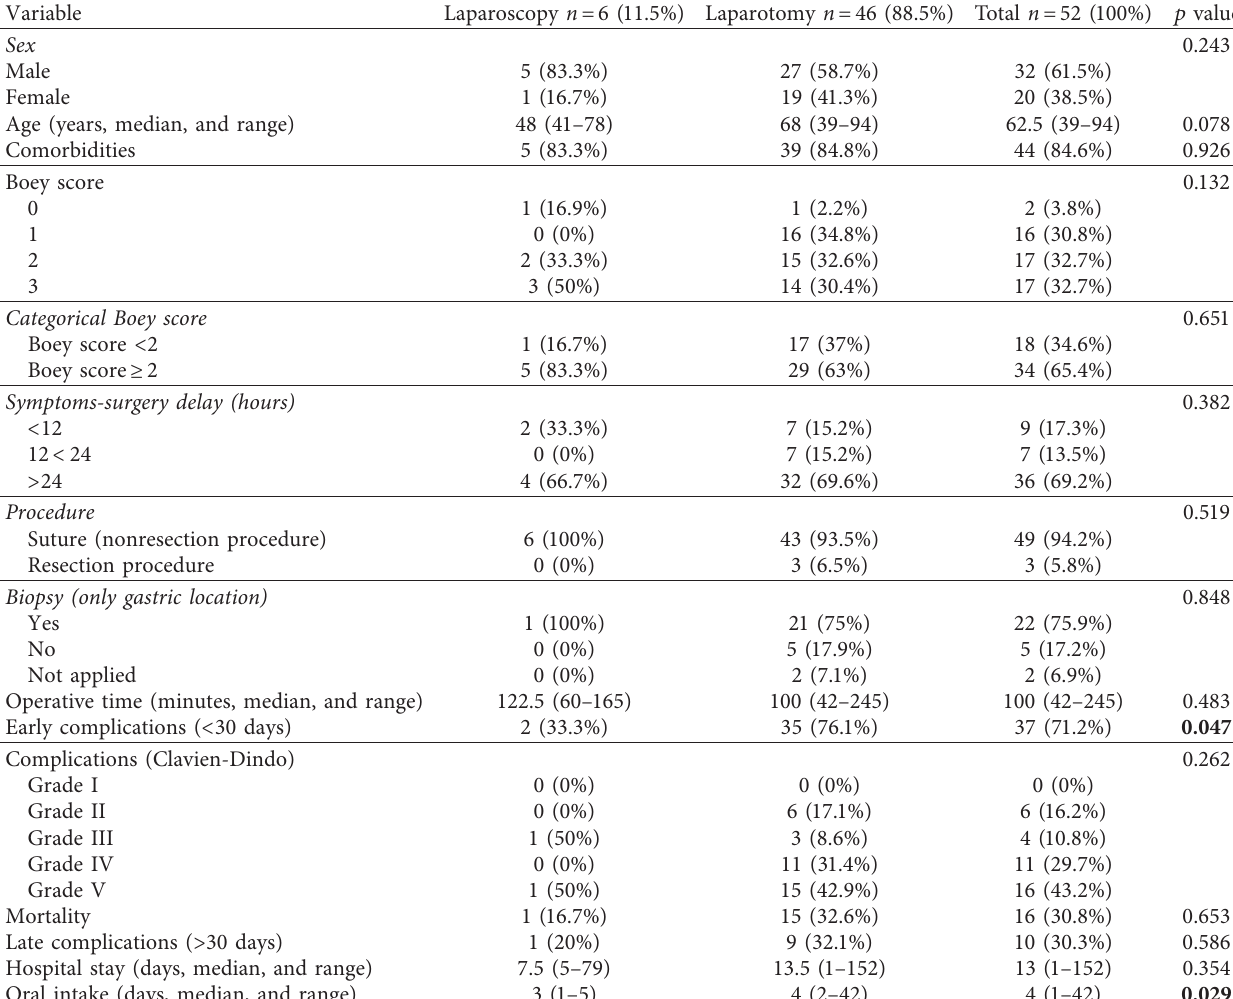
Table 2: Surgical approaches, sepsis group ( n �